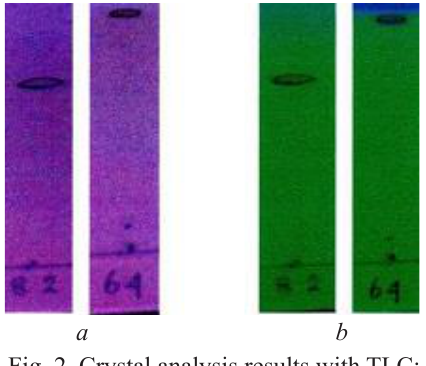
a b Fig. 2. Crystal analysis results with TLC: ( a ) UV ; ( b ) UV λ 254 nm λ 366 nm